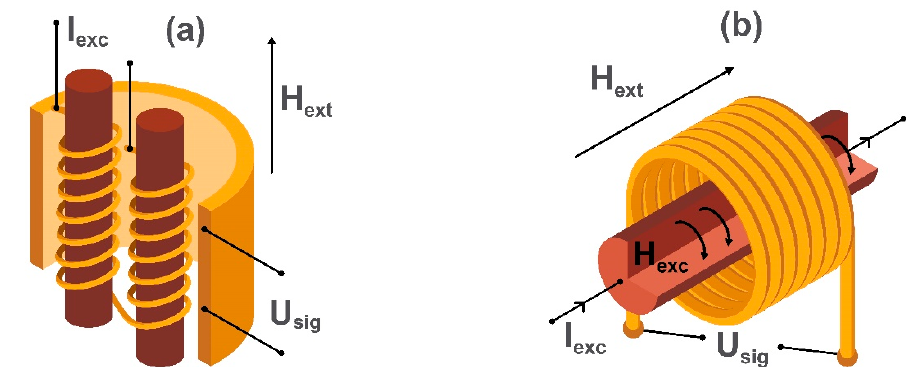
Figure 4. Schematic images of the sensing elements: ( a ) a parallel fluxgate magnetometer and ( b ) an orthogonal fluxgate magnetometer using a magnetic microwire. H ext is the applied external magnetic field, I exc is an alternating excitation current producing the excitation magnetic field H exc , and U sig is the voltage generated in the detection coil.